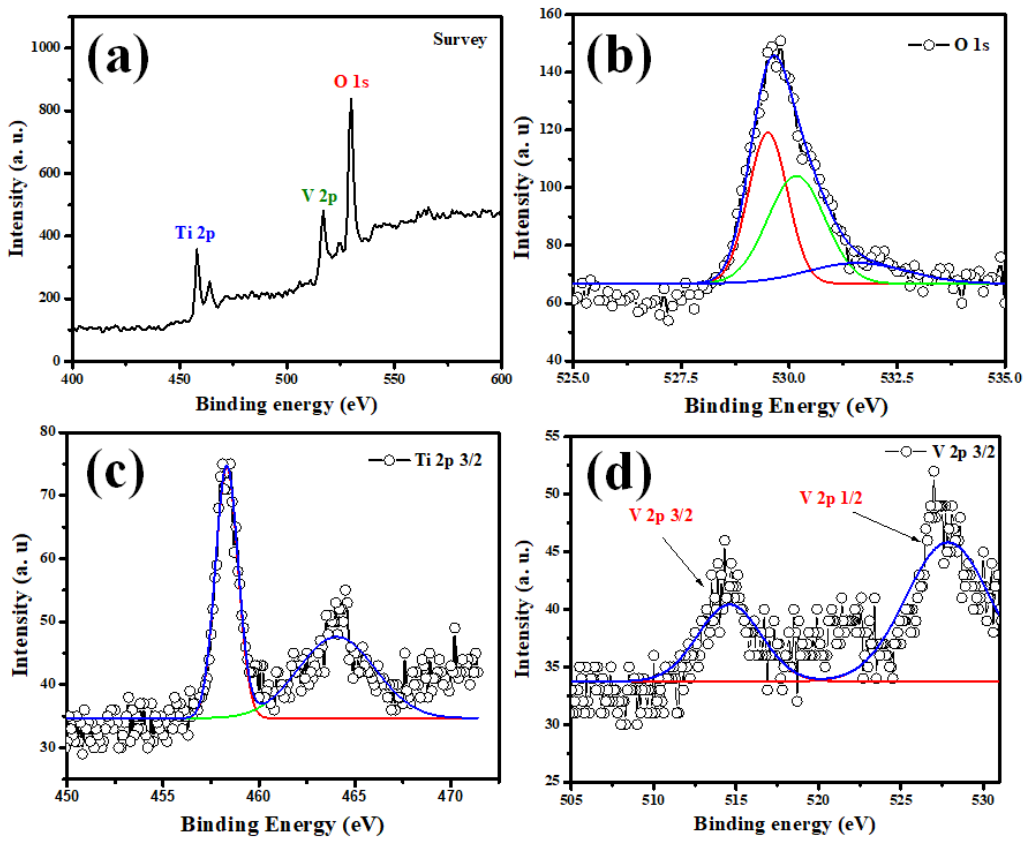
Figure 3. Extraordinary resolution XPS spectra of ( a ) Survey ( b ) O1s, ( c ) Ti 2p 3/2, and ( d ) V 2p 3/2 of V 2 O 5 -TiO 2 nanohybrid.